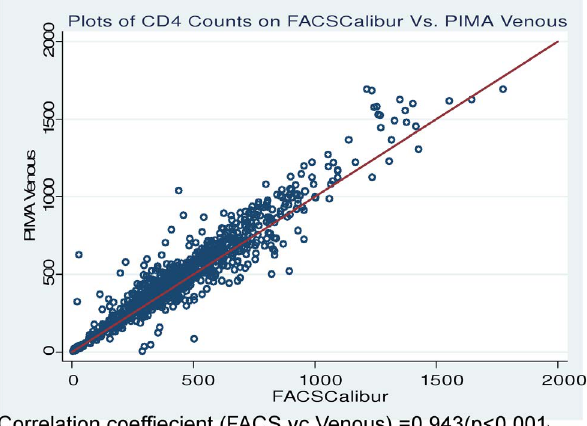
Figure 1. Scatter plots of FACSCalibur Vs PIMA measurements.